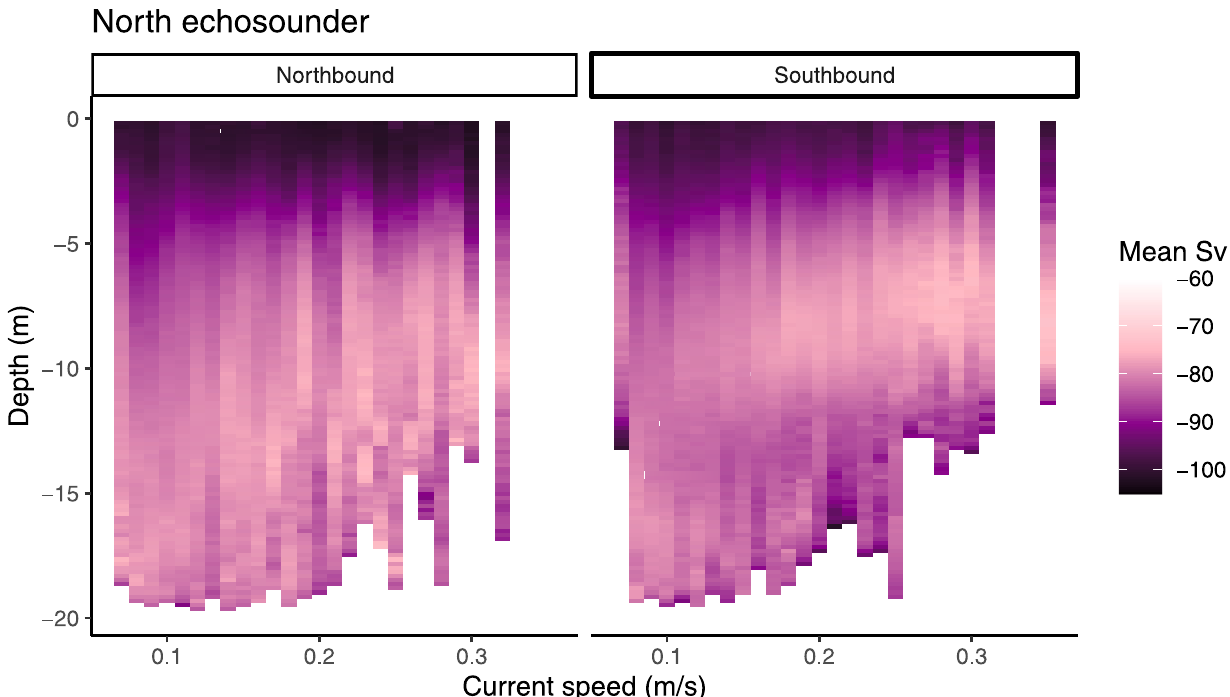
Fig 11. Depth and dispersal of fish over current. The upper and lower panels indicate the two echo sounders, and the left and right panels the direction of current. Back scatter strength ( S v ) indicates fish density, with higher values (-70) indicating many fish and lower values (-100) indicating fewer fish. Data presenting shoal depth during the night is not included for simplicity.